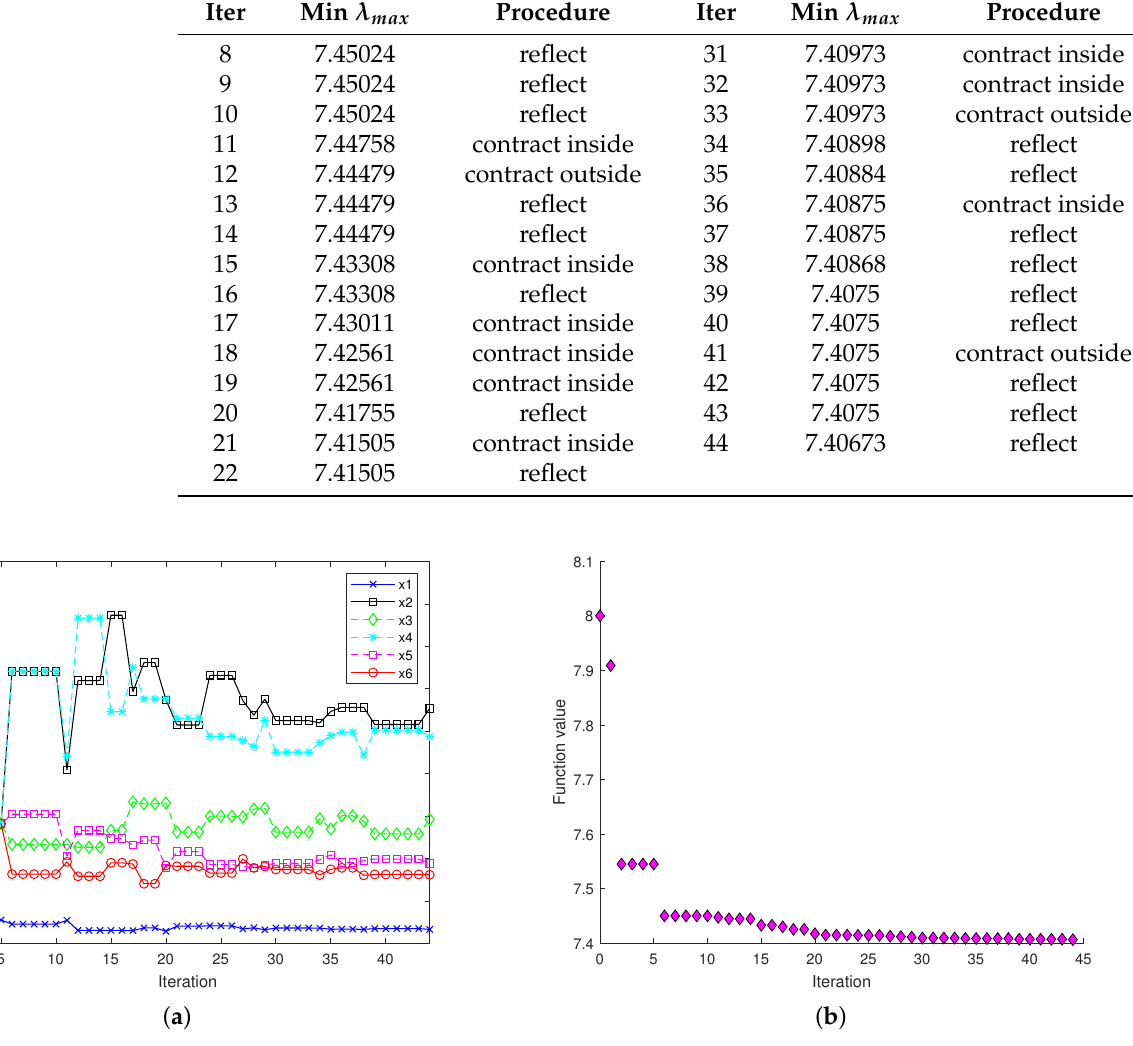
Figure 2. The values of x 1 , . . . , x 6 , and the first 44 iterations of the algorithm with the function value for minimization (13): ( a ) evolution of the variables with respect to iterations; and ( b ) function value vs.